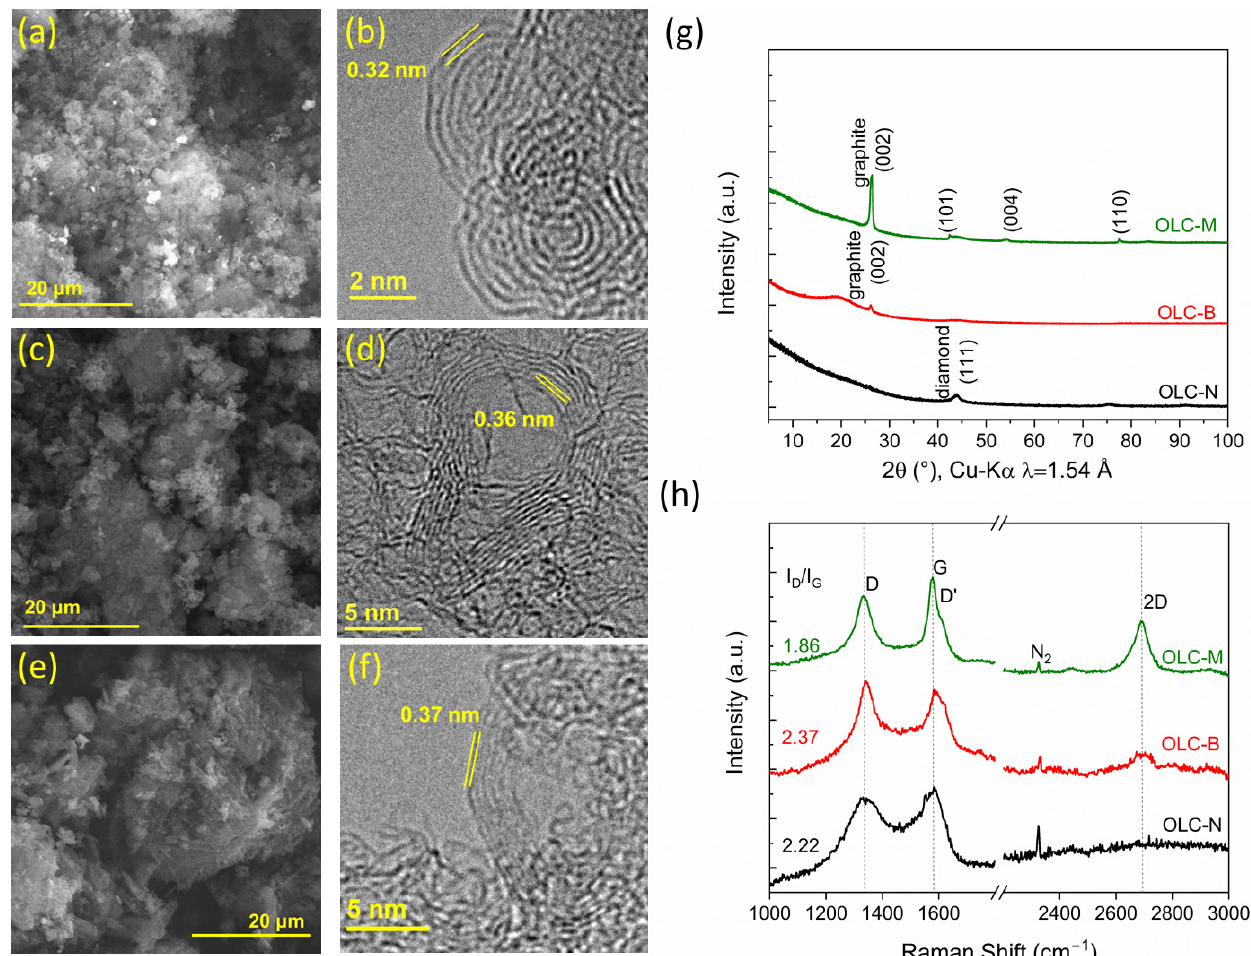
Figure 2. SEM images (SE detector) and HR-TEM images of ( a , b ) OLC-N, ( c , d ) OLC-B, and ( e , f ) OLC-M, ( g ) as well as XRD patterns and ( h ) Raman spectra for all OLC samples.